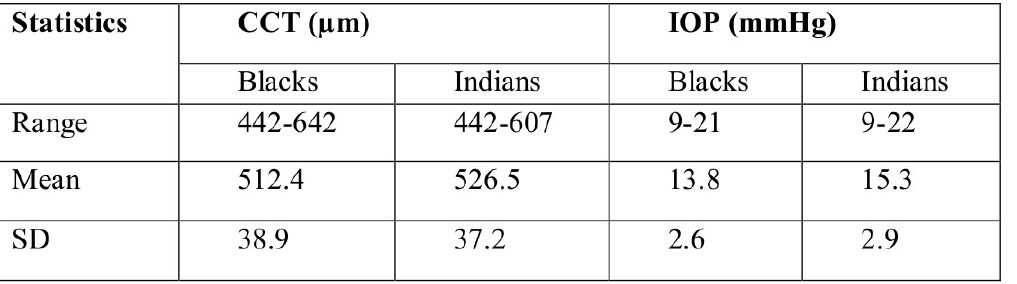
Table 1: Showing the range, mean and standard deviation (SD) of CCT and IOP in the two groups. The mean CCT and IOP values are higher in Indians than in Blacks.